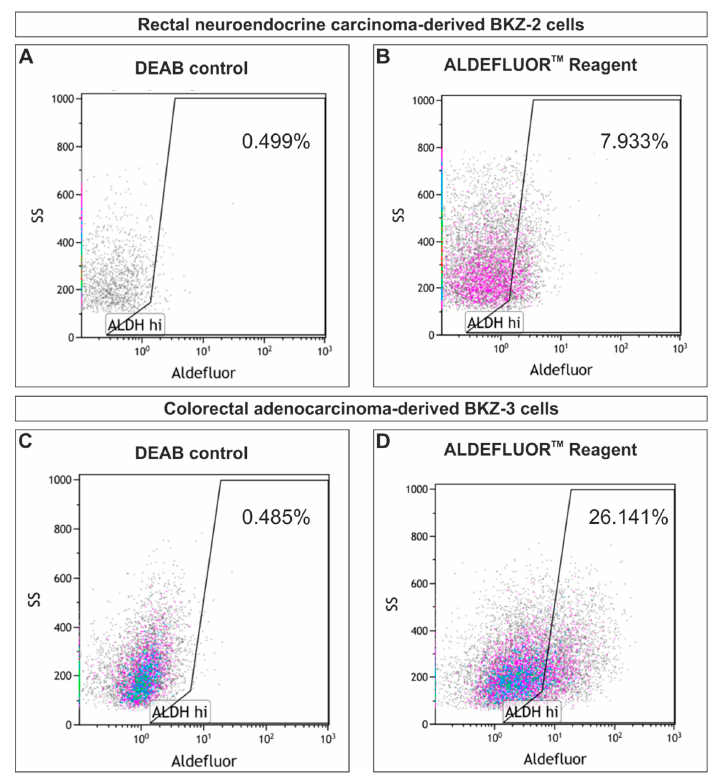
Figure 6. BKZ-2 and BKZ-3 both show aldehyde dehydrogenase (ALDH) activity. Flow-cytometric-analysis of ALDH activity of ( B ) BKZ-2 and ( D ) BKZ-3 revealed 7.993% ALDH high cells for BKZ-2 and 26.141% ALDH high cells for BKZ-3 in comparison to the appropriate ( A/C ) control with the specific ALDH inhibitor diethylaminobenzaldehyde (DEAB).